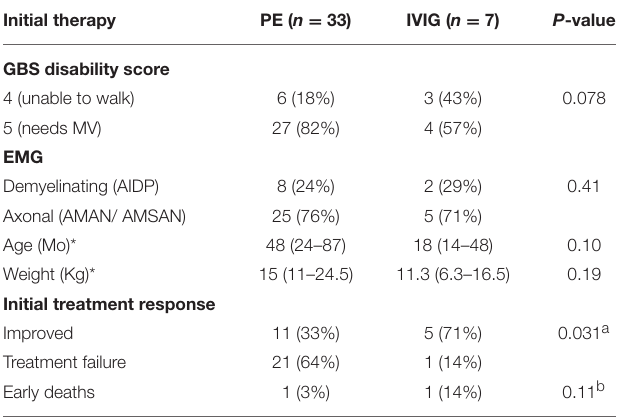
TABLE 1 | Descriptive data of enrolled cases and their initial treatment response.